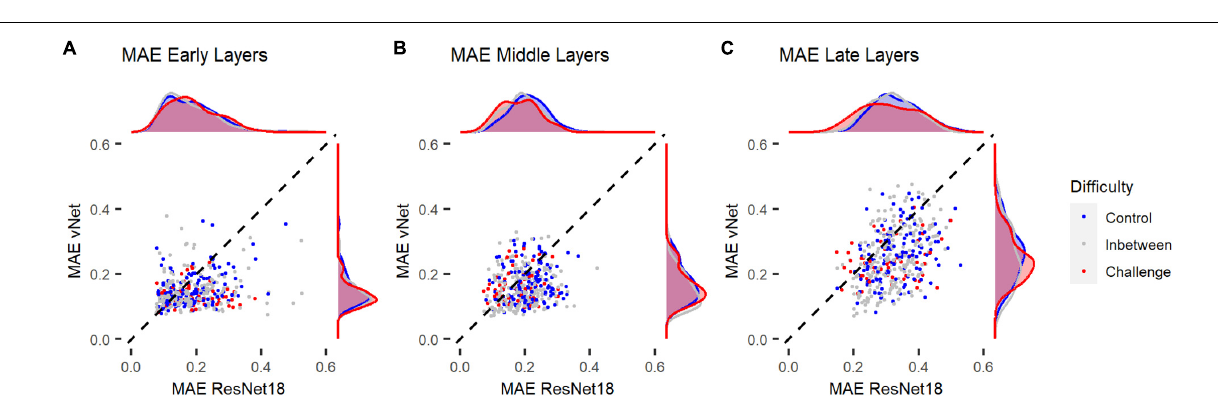
FIGURE 9 | Mean absolute error (MAE) of ResNet18 and vNet from human observer heatmaps for individual images. Control images were categorized correctly by human observers, ResNet18, and vNet, while challenge images were categorized correctly by human observers but categorized incorrectly by ResNet18 and vNet. (A,B) MAEs seemed to be lowest in early layers. Here, the funnel shaped distribution hinted toward a lower boundary which may be a consequence of the discrete scale of GradCAMs. (C) As the distribution spread apart in later layers, the clearly smaller MAE of vNet became visible as more images could be found below the diagonal break-even